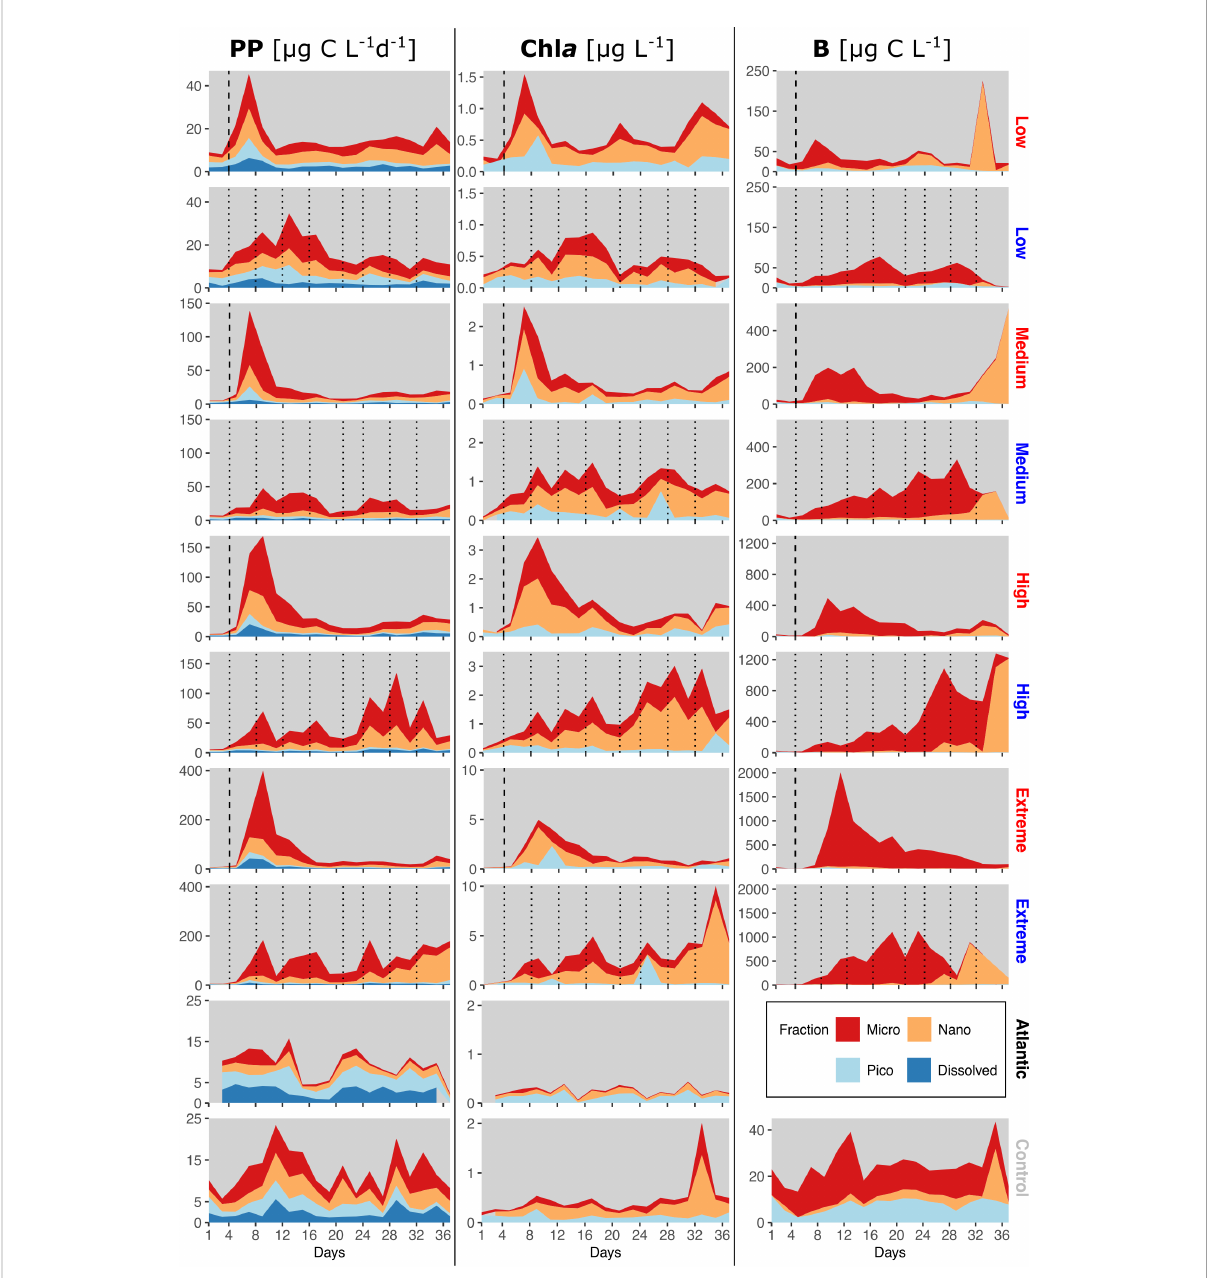
FIGURE 4 Relative size class contributions of micro-, nano- and picoplankton to total PP rates, Chla concentration and phytoplankton C. PP plots also include PP DOC rates. Mind the different y-axis scales. The blank spot in the Atlantic between d35-37 is due to one missing data point. Dotted lines represent DW additions, dashed line marks the single DW addition to singular treatments. Recurring treatments labelled in blue, singular in